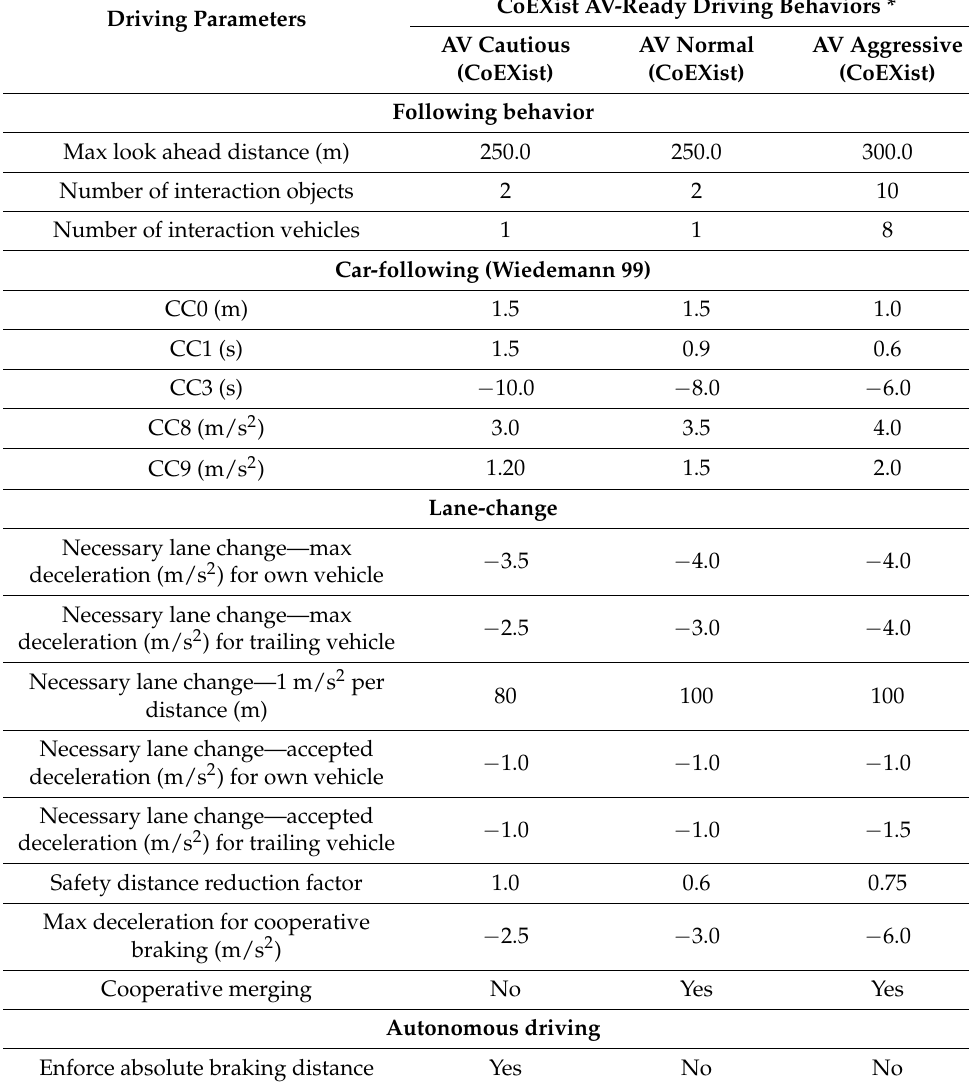
Table 9. Driving behavior parameters for three different AV-ready logics. Driving